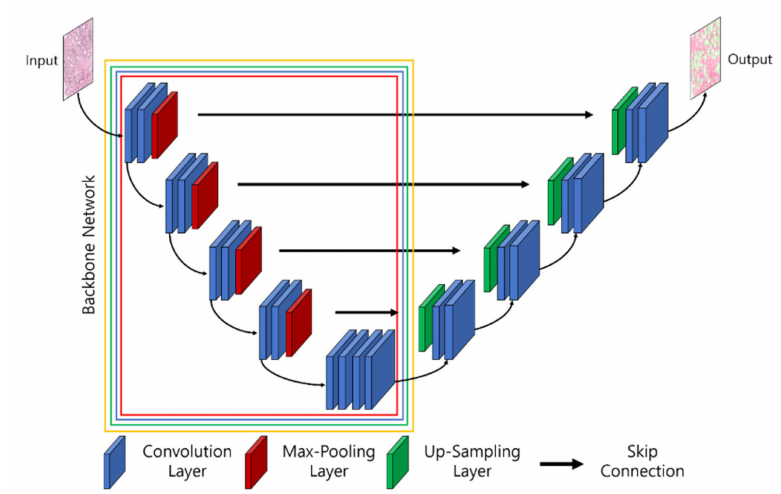
Figure 5. The architecture of UNet and the pretrained convolution neural network (i.e., backbones for feature extraction). The parts of the backbone network marked with red, blue, green, and yellow signify Resnet34-UNet, ResNeXt50-UNet, InceptionV3-UNet, and EfficientNetB2-UNet.